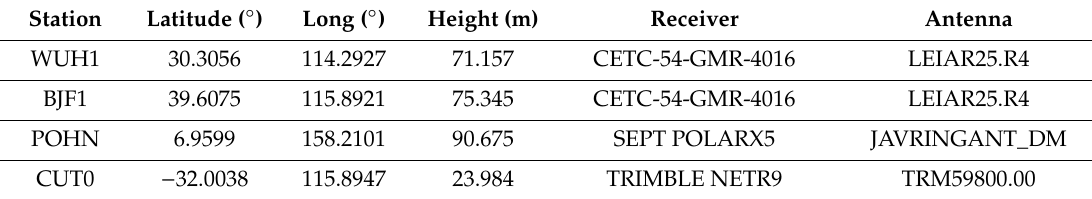
Table 1. Details of the four selected GNSS